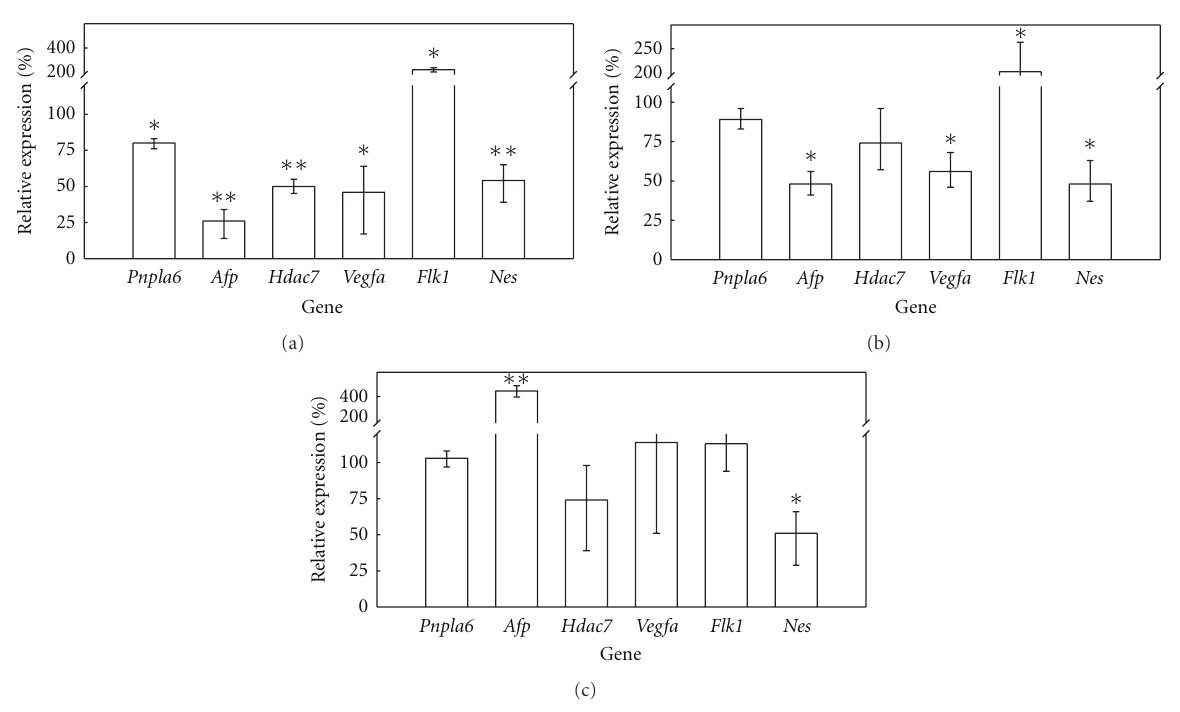
Figure 2: E ff ect of 5-FU, DPH, and saccharin on D3 di ff erentiation. Monolayer cultures of D3 cells under spontaneous di ff erentiation (in the absence of LIF) were exposed to either 50 ng5-FU/mL (a), or 75 μ g DPH/mL (b), or 1000 μ g saccharin/mL (c) over 5 days. When exposure ended, RNA was extracted, and the gene expression of the biomarkers of di ff erentiation was assayed by quantitative RT-PCR according